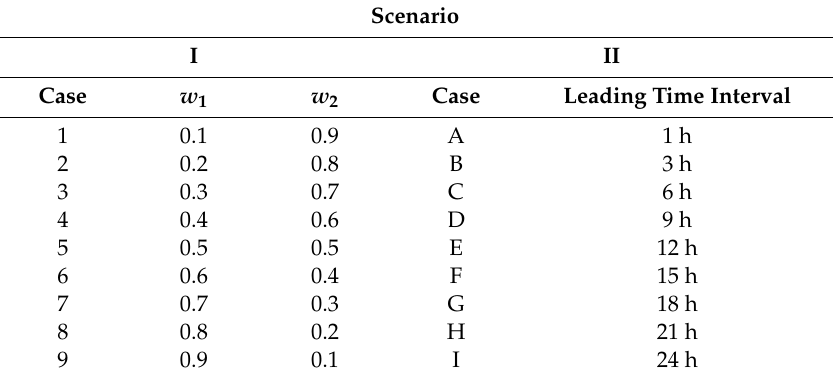
Table 6. Simulation cases for the application of the hybrid activation function.